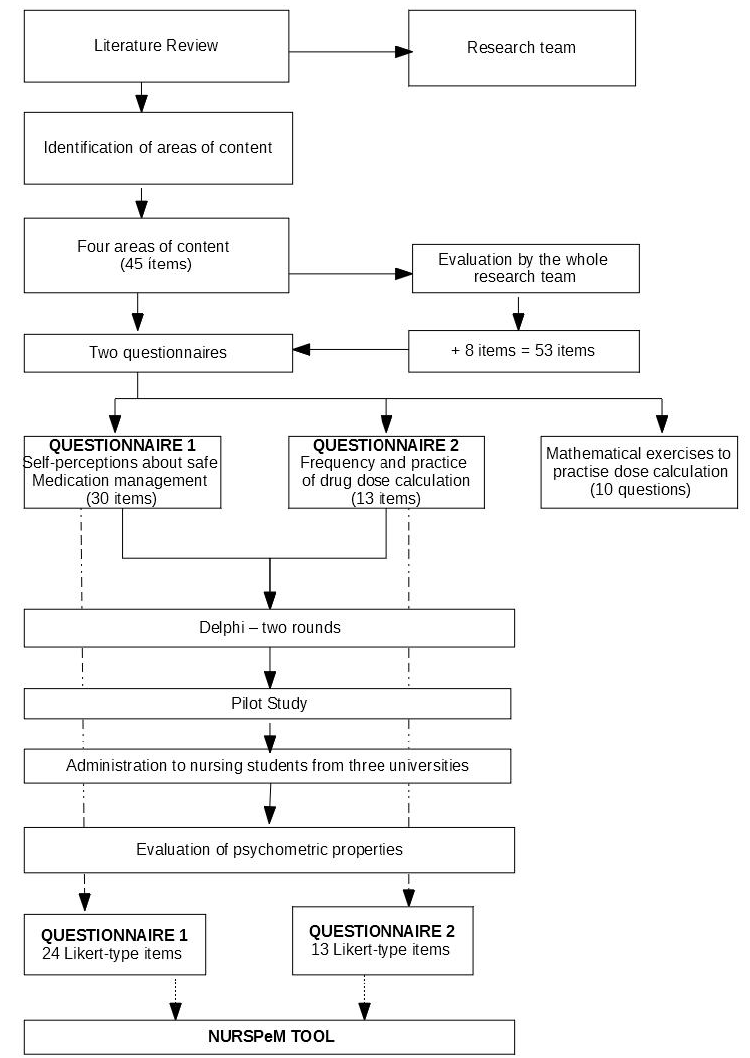
Figure 1. Flowchart showing the process of developing the NURSPeM.